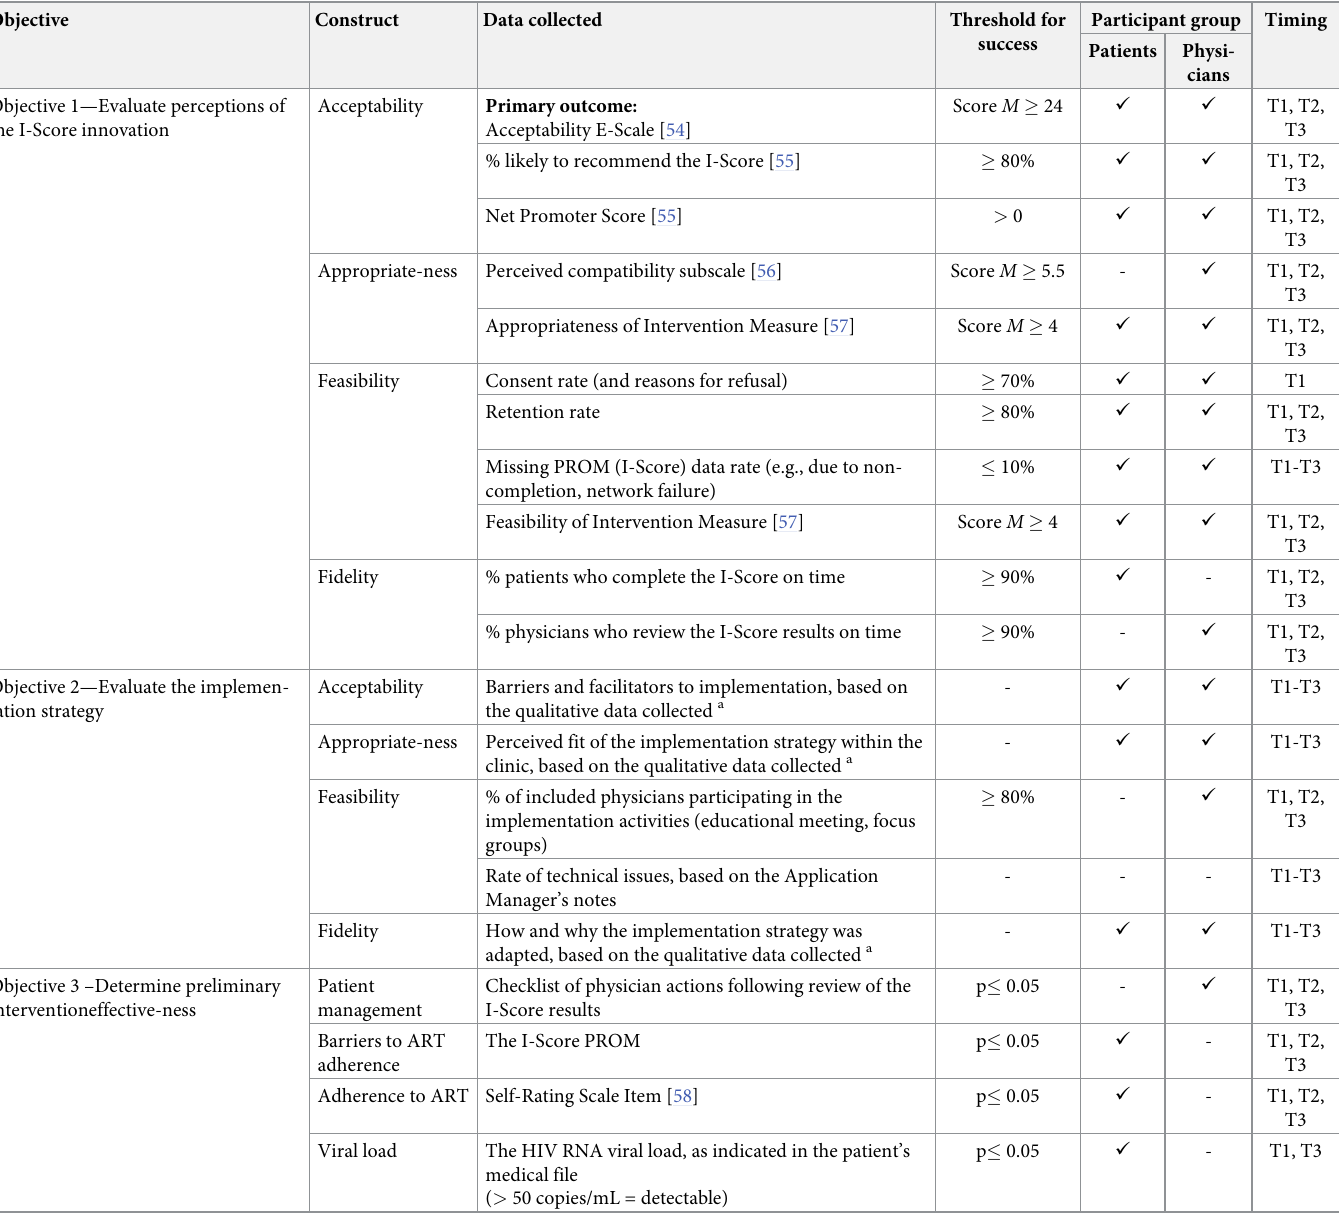
Table 2. Implementation science metrics and effectiveness outcomes collected for the pilot study.